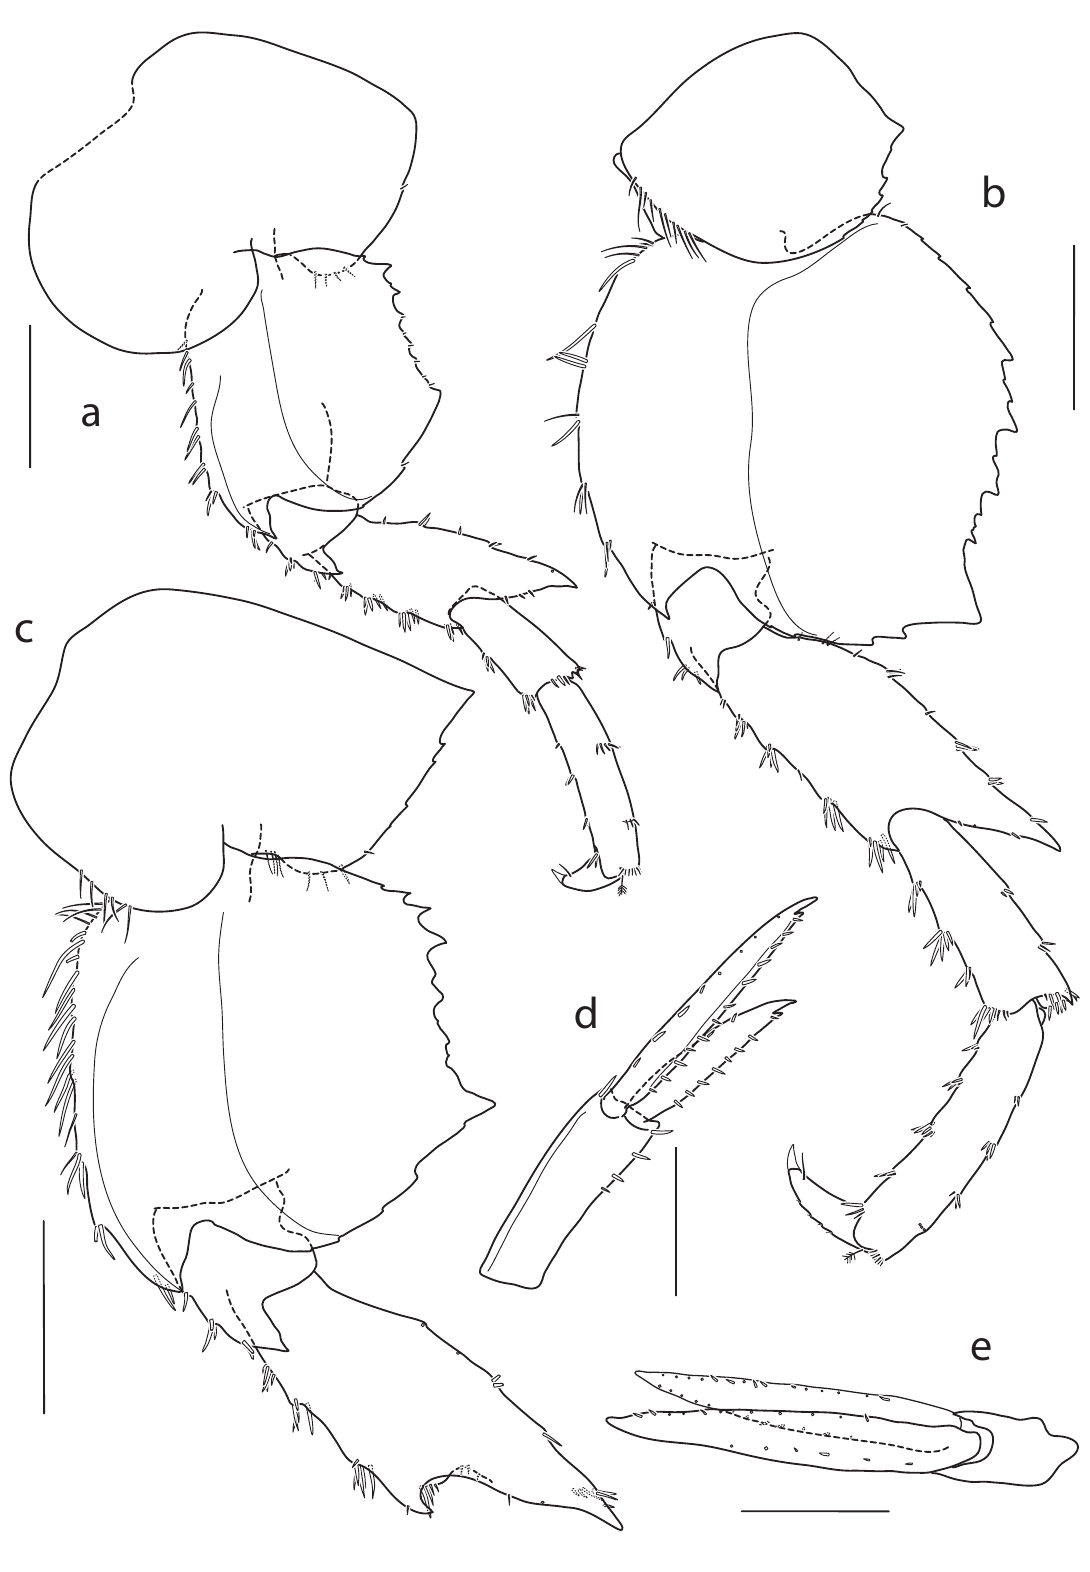
Fig. 22. Labriphimedia vespuccii K.H. Barnard, 1931, ♀, 21 mm (ZMB 34096). a . Pereopod 5. b . Pereopod 7. c . Pereopod 6. d . Uropod 2. e . Uropod 3. Scale bars = 1